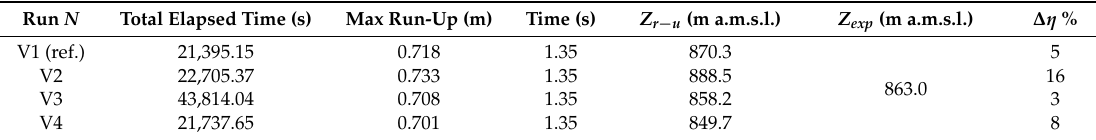
Maximum run-up obtained in the numerical simulations and comparison with the experimental